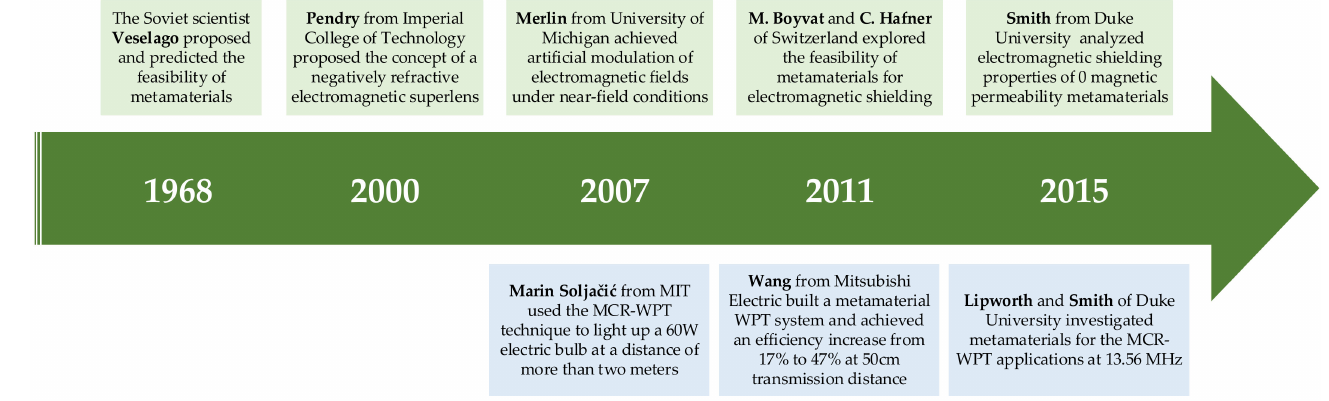
Figure 10. The joint development history of metamaterials and WPT